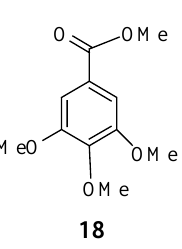
Figure 3 : Methyl